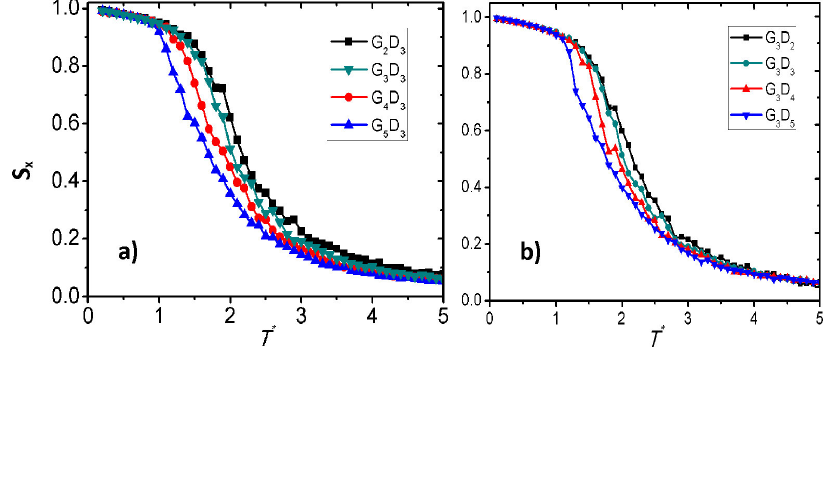
Figure 11. Average orientational order parameter as a function of temperature, T ∗